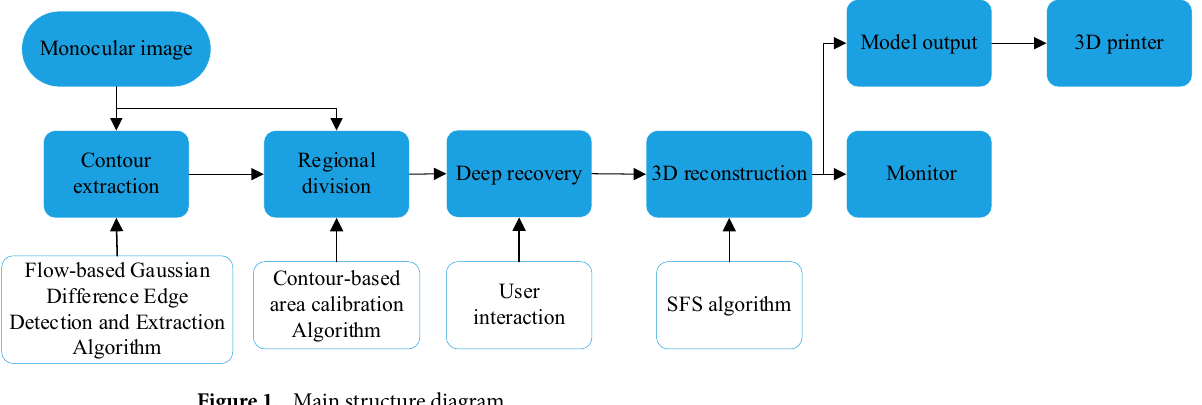
Figure 1. Main structure